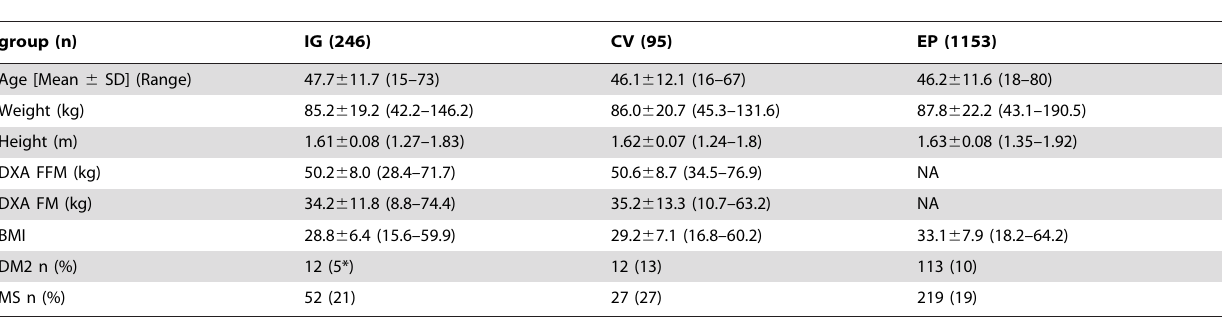
Table 1. Characteristics of the study populations.